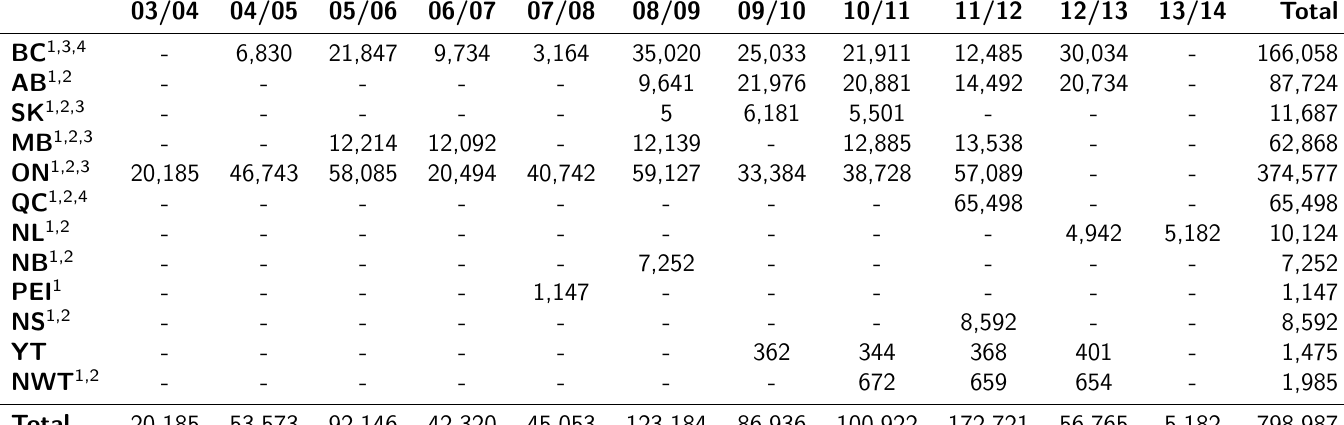
Table 1: Distribution of EDI Records in the CanNECD Database by Canadian Province/Territory and